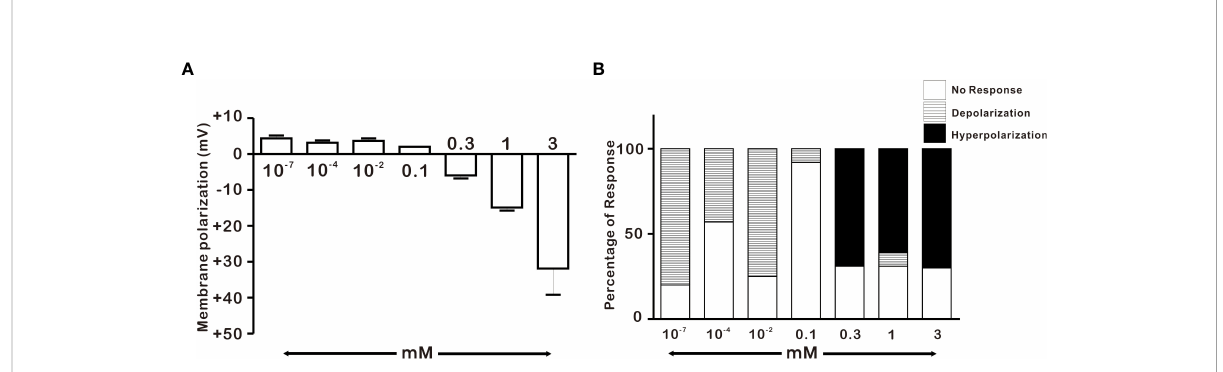
FIGURE 3 Concentration-dependent effect of H 2 O 2 on GnRH membrane potential under whole-cell current clamp. (A) Histograms depicting H 2 O 2 - induced membrane polarization in response to various concentrations of H 2 O 2 on GnRH neurons of adult males (one-way ANOVA post-hoc Scheffe test) (B) Histograms depicting percentage of variegated responses induced by various concentrations of H 2 O 2 on GnRH neurons of adult males.